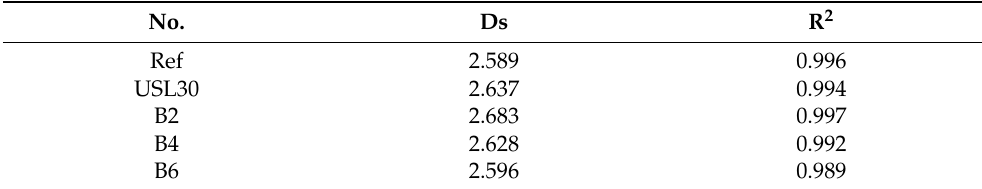
Table 6. Ds of the UHPC paste at 28